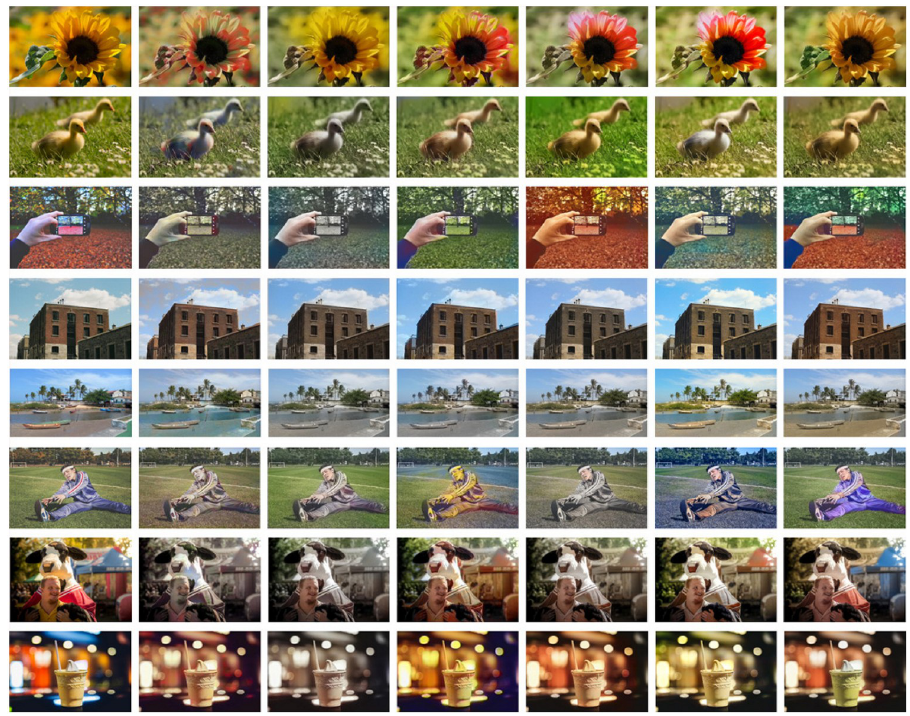
Fig 7. Recolor of natural images. The first four are simple natural scenes such as the lawn, single object, the sky and simple architecture, while the last four are complex natural scenes such as the water, many objects, brilliant lights and complex color levels. Literature [48] has two ways of automatic coloring and manual coloring, and the effect of automatic coloring is shown here. (a) GT, (b) [16], (c) [17], (d) [18], (e) [47], (f) [48], (g) Ours.